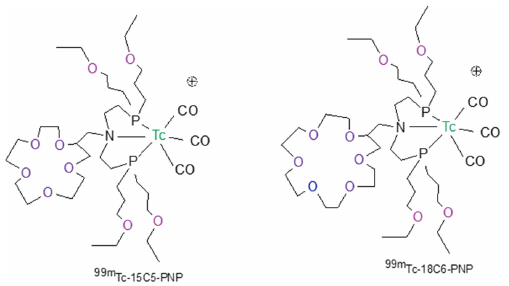
Figure 4. Chemical structures of the most representative [ 99m Tc]Tc(I)-tricarbonyl radiotracers for myocardial perfusion imaging. A different tridentate ligand containing the functionalized tris(pyrazolyl) methane chelators was used to develop promising heart imaging agents with the [ 99m Tc][Tc(CO) 3 ] + core [59]. The functionalization of the tris(pyrazolyl)methane chelators with two or three methoxymethyl groups at the azole rings allowed for the modulation of the biodistribu-